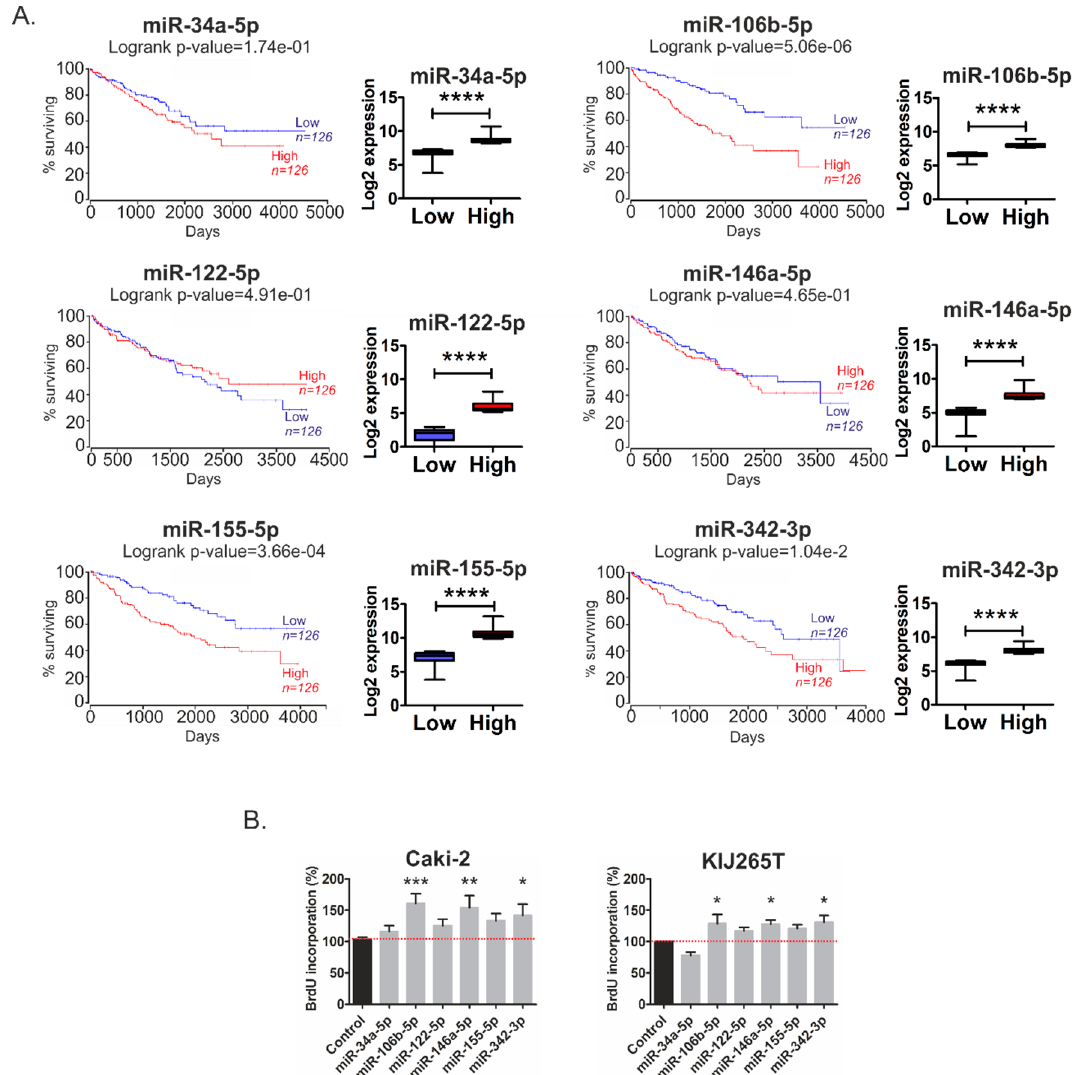
Figure 3. MicroRNAs effects on survival of RCC patients and proliferation of RCC cells. ( A ) Kaplan–Meier plots of RCC patients generated using OncoLnc tool and KIRC cohort of TCGA data. Patients were classified into Low and High expression groups basing on median miRNA expression data, which are shown on the graphs below the K-M plots. **** p < 0.0001; analysis was done using Mann–Whitney test. ( B ) The effects of microRNAs on proliferation of Caki-2 and KIJ265T cells. The plots show results of BrdU assay performed in three independent biological experiments. Statistical analysis was done using repeated measures ANOVA with Dunnett‘s Multiple Comparison post-test. * p < 0.05, ** p < 0.01, *** p < 0.001.